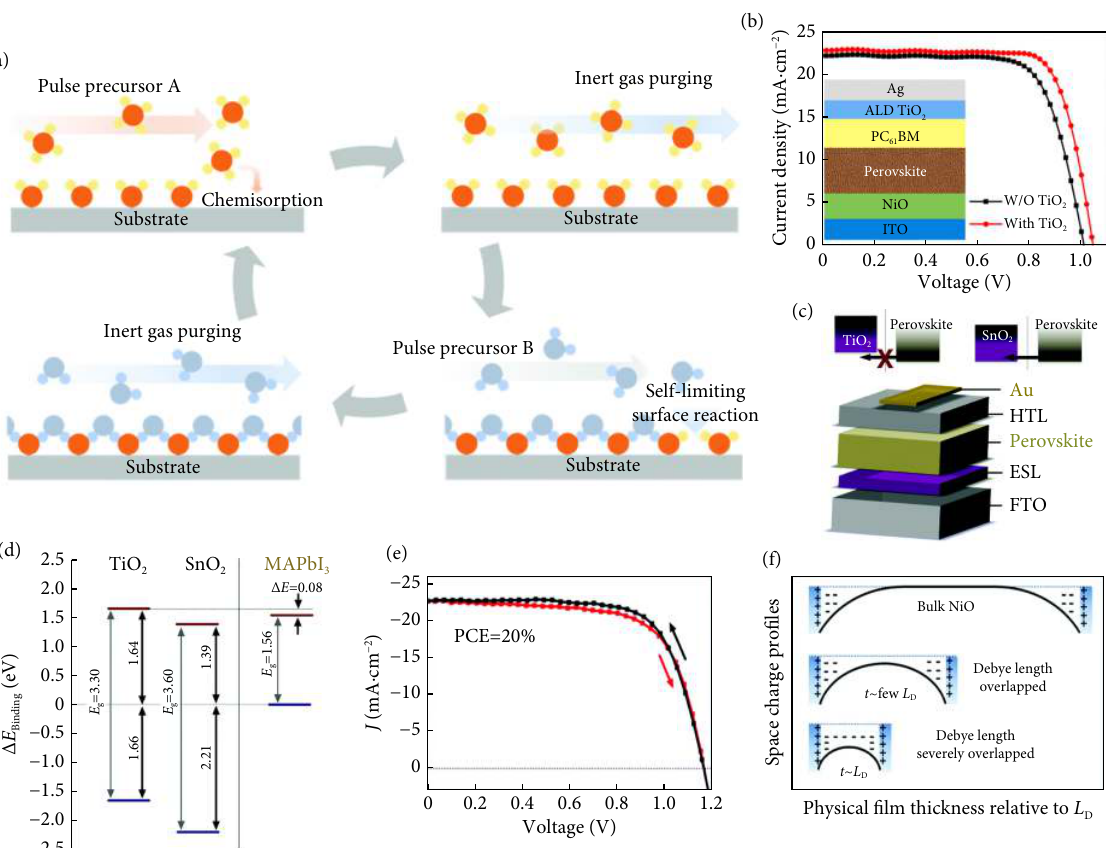
Fig. 5 ALD for CTLs. (a) Schematic illustration of the ALD process (reprinted with permission from ref. [45], © 2019 The Royal Society of Chemistry). (b) Device structure and J–V curve of PSC using ALD-TiO 2 as ETL (reprinted with permission from ref. [65], © 2018 American Chemical Society). ( c and d ) Schematic conduction band diagram of the perovskite films and the electron selective layers, TiO 2 and SnO 2 for MAPbI 3 PSCs (reprinted with permission from ref. [69], © 2015 The Royal Society of Chemistry). (e) Current-voltage characteristics of the PSC using ALD-SnO 2 as ETL (reprinted with permission from ref. [70], © 2017 The Royal Society of Chemistry). (f) Schematic images of physical film thickness relative to the Debye length versus space charge profiles (reprinted with permission from ref. [72], © 2016 The Royal Society of